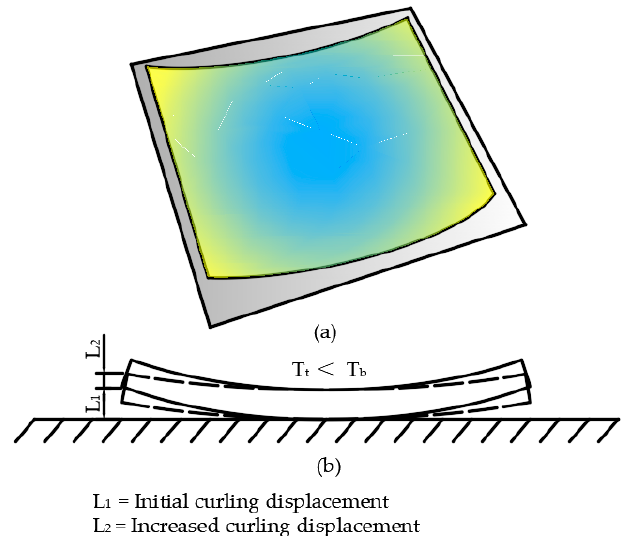
Figure 7. Increased curling deformation of concrete pavement. ( a ) Spatial diagram and ( b ) plan- form.